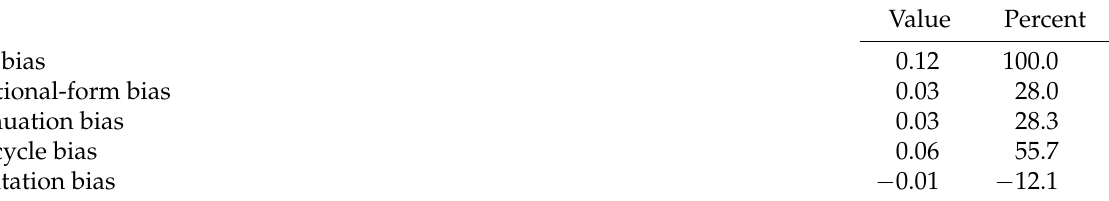
Table 5: Across-models Shapley decomposition of total bias in IGE e